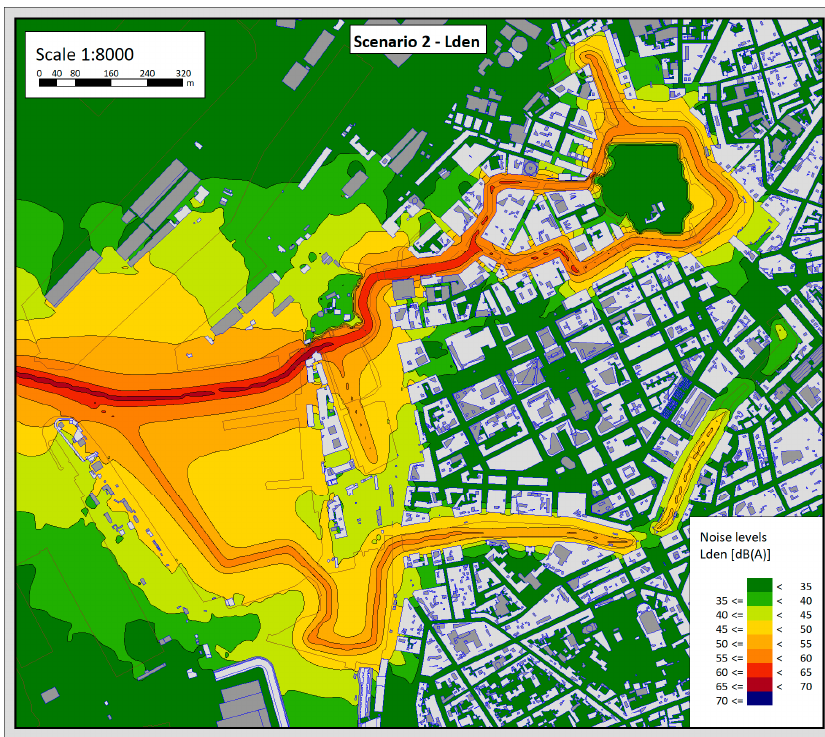
Figure 8. Map of the noise produced by small vessels in the port and internal canals of Livorno.